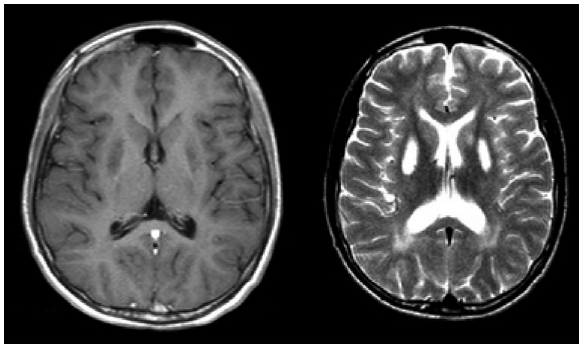
Figure 2. MRI showing bilateral basal ganglia lesions with hypointensity on T1- and hyperintensity on T2-weighted